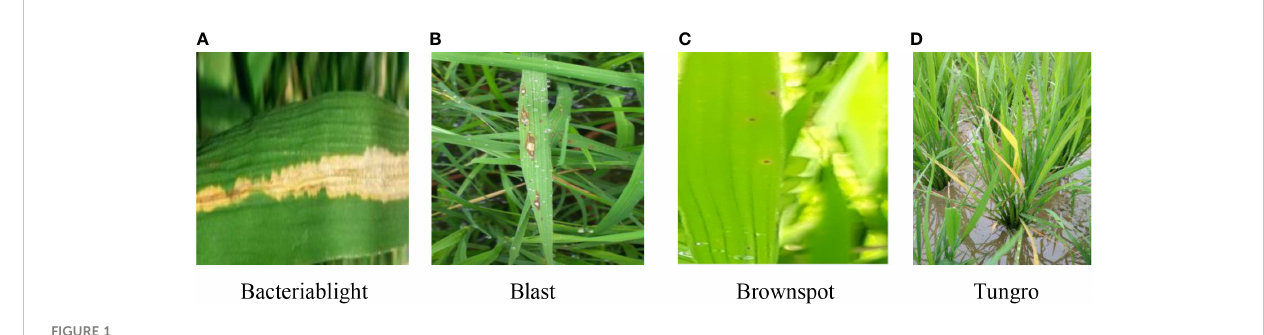
FIGURE 1 Sample images of rice